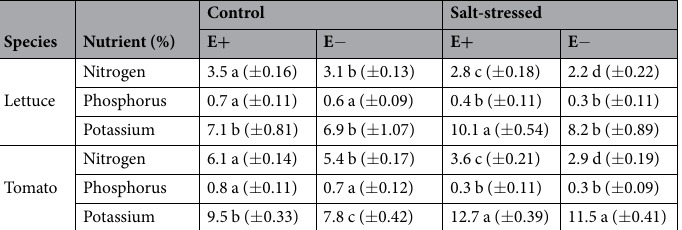
Table 2. Concentration of nutrients (% of dry weight) in foliar tissues of lettuce and tomato plants grown for 90 and 100 days, respectively, under 50 mM NaCl (Control) and 150 mM NaCl (Salt-stressed) in the presence (E + ) or absence (E − ) of root fungal endophytes. Values are means ± SD (n = 20). Different lowercase letters indicate significant differences among treatments for each nutrient by species combination (Tukey HSD tests; α =